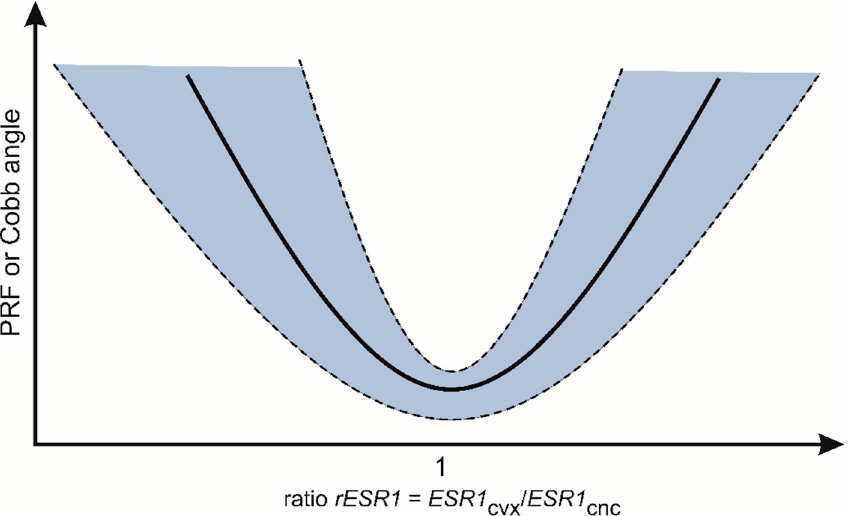
Figure 4. Relationship between the ESR1 expression asymmetry ( rESR1 ) and two phenotype parameters: the scoliosis angle (Cobb angle) or the Progression Risk Factor (PRF). The two phenotype parameters, denoting the scoliosis magnitude and the scoliosis deterioration risk, respectively, revealed minimal values in patients presenting symmetry of ESR1 expression ( rESR1 of about 1).